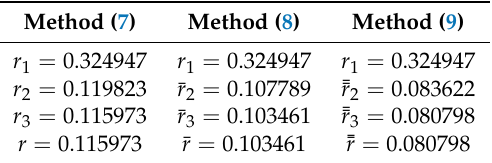
Table 1. Numerical results for Example